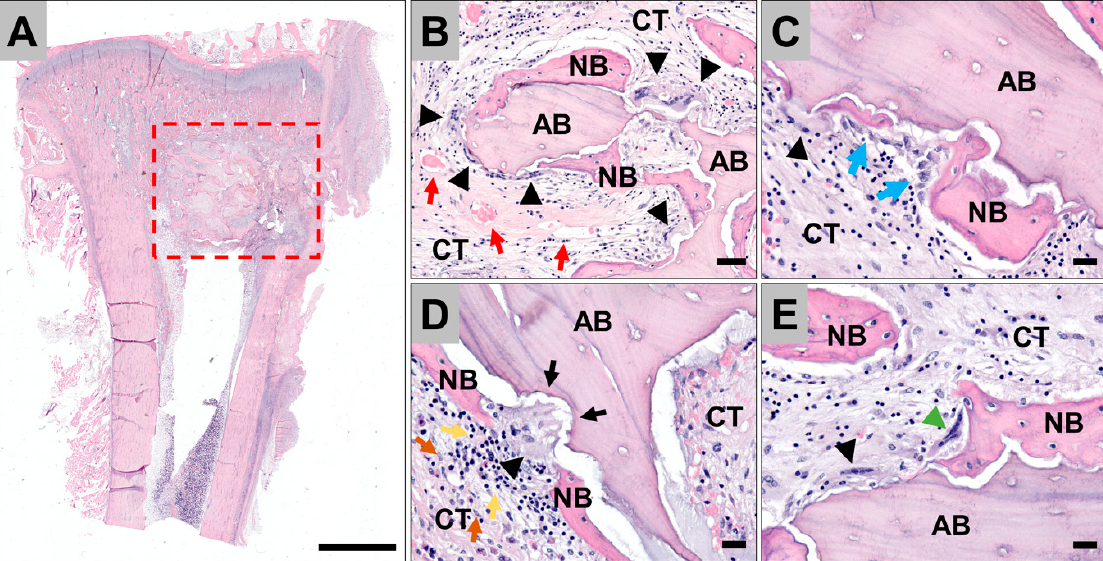
Figure 5. Illustrative histological images of allogeneic bone blocks impregnated with vancomycin implanted in rabbit tibia at 120 days post implantation. Overview of the implantation bed of the allogeneic bone block (red box) ( A ). Closeups of the allogenic bone graft (AB) and new bone growth (NB), surrounded by connective tissue (CT), vessels (red arrows), osteoblasts (blue arrows), osteoclasts (green arrowheads), multinucleated giant cells (MNGCs) (black arrowheads) with visible resorption lacunae (black arrows), lymphocytes (yellow arrows), and macrophages (orange arrows) ( B–E ). H&E-stainings, ( A ) 100× magnification, scalebar = 250 µm, ( B ) 20× magnification, scalebar = 50 µm, and ( C , E ) 40× magnification, scalebars = 20 µm.